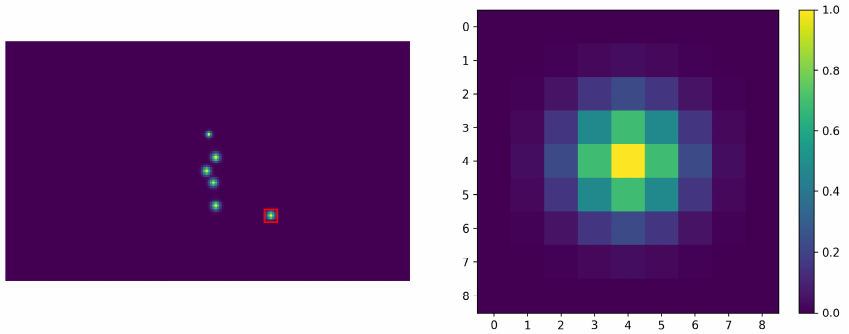
Figure 8. Example of Gaussian kernel. The image on the right is a partial enlargement of the red area in the image on the left.